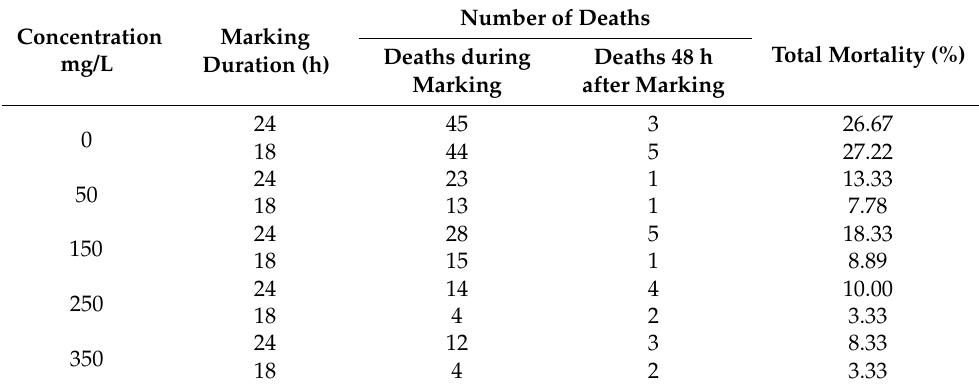
Table 3. Effects of CAL staining on juvenile fish mortality (180 test fish per